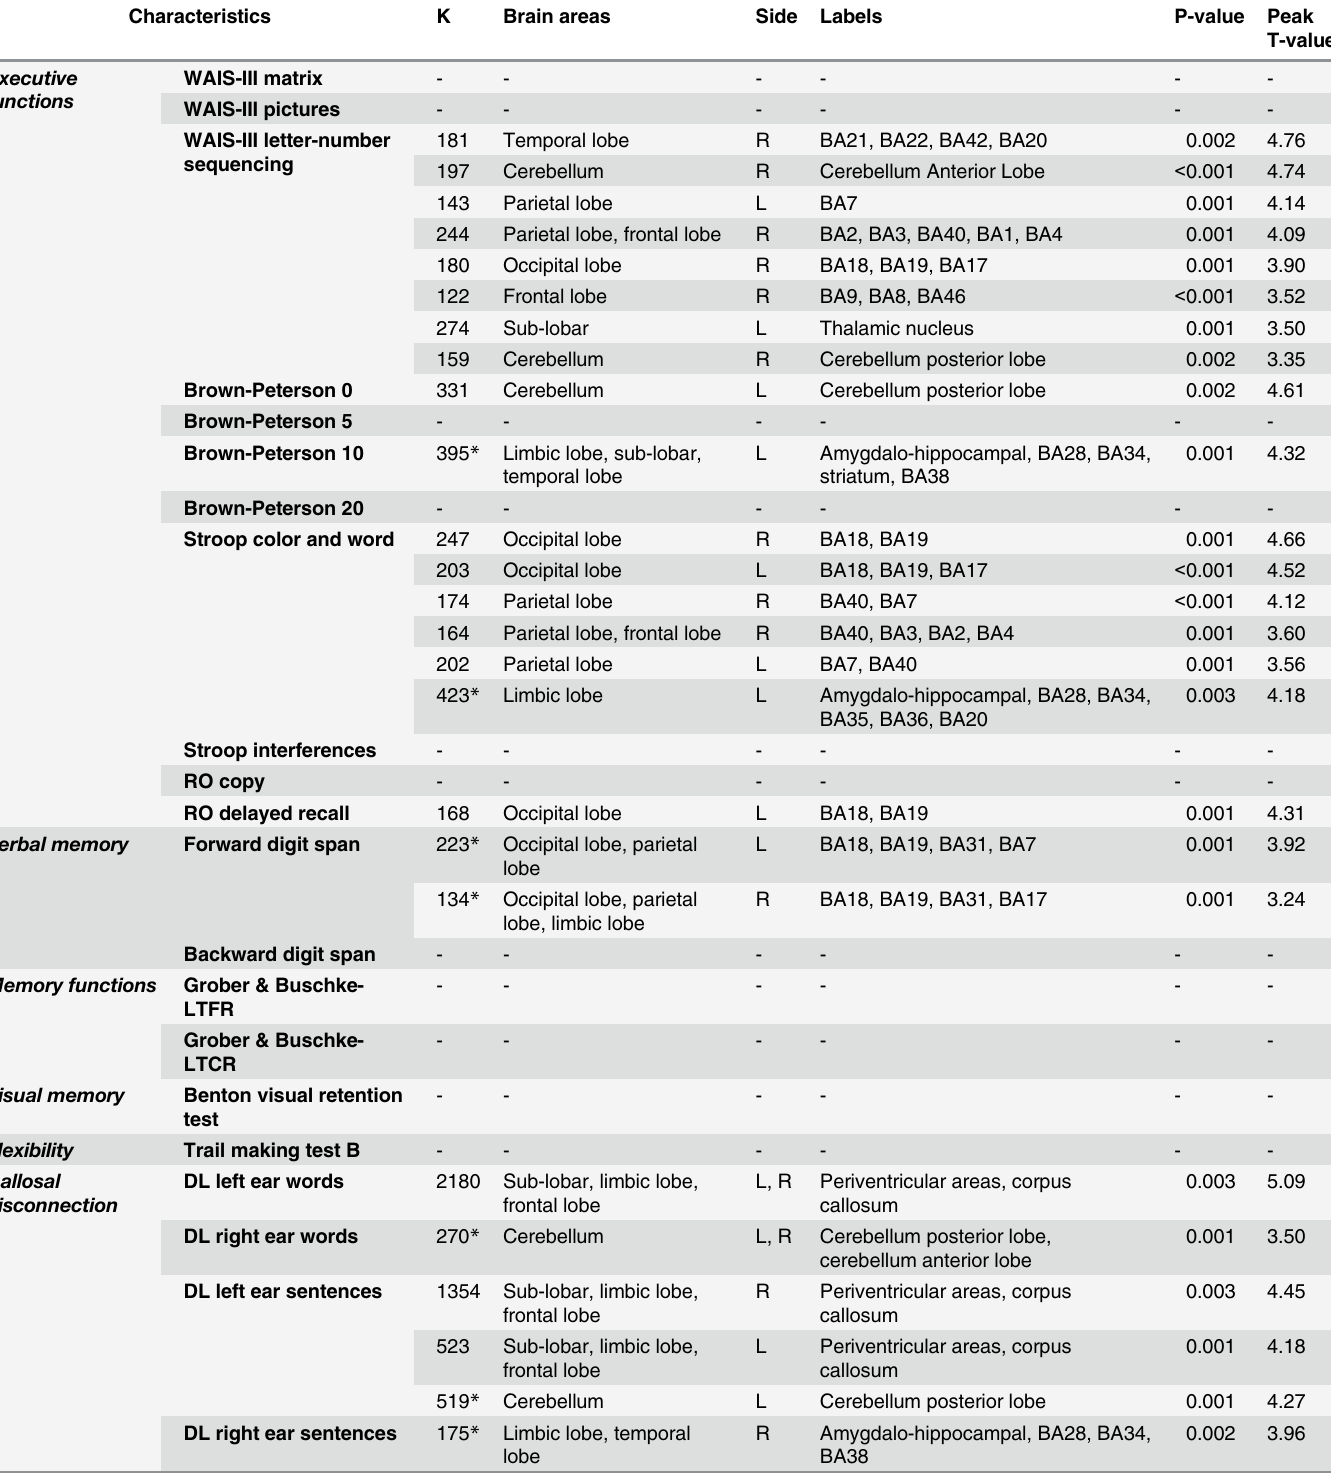
Table 2. Linear regression analyses of cognitive scores and time since last vaccine injection, with adjustment for age, sex, socio-cultural level and delay between brain SPECT and neuropsychological testing. Characteristics